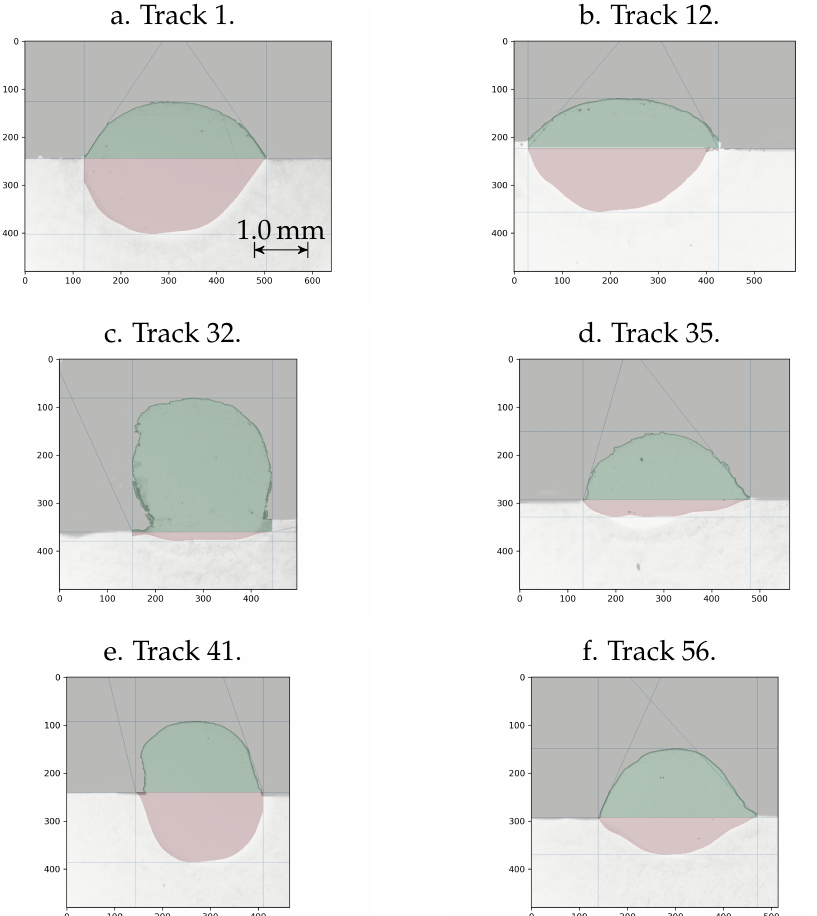
Figure 12. Examples of processed images with the elaborated algorithm (scale in pixels): the areas above and below the substrate are green and red, respectively; lines indicative of the width, height, substrate line, wettability angles and penetration limit are shown in blue. The images ( a ), ( b ), ( c ), ( d ), ( e ) and ( f ) are Tracks 1, 12, 32, 35, 41 an 56, respectively. Scale in the original image was added in post-processing and was not part of the image during the execution of the code.